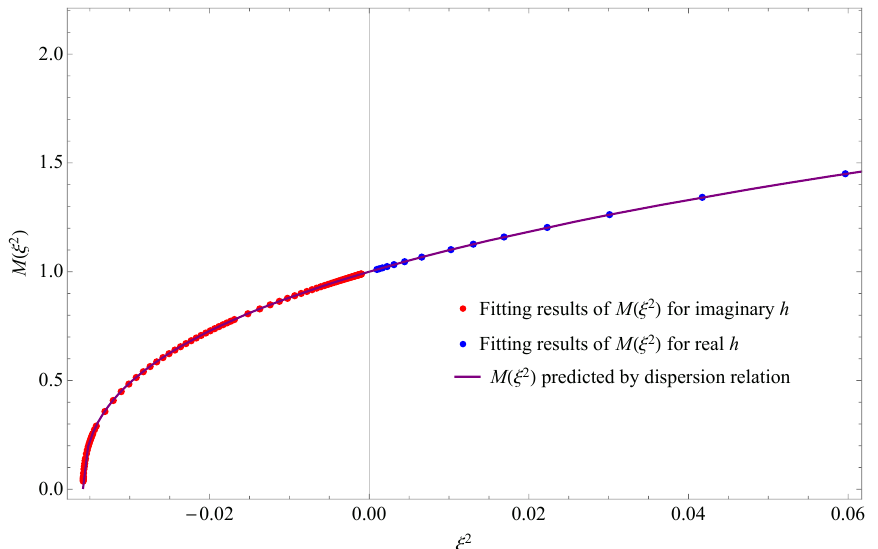
, with real and imaginary h denoted 0